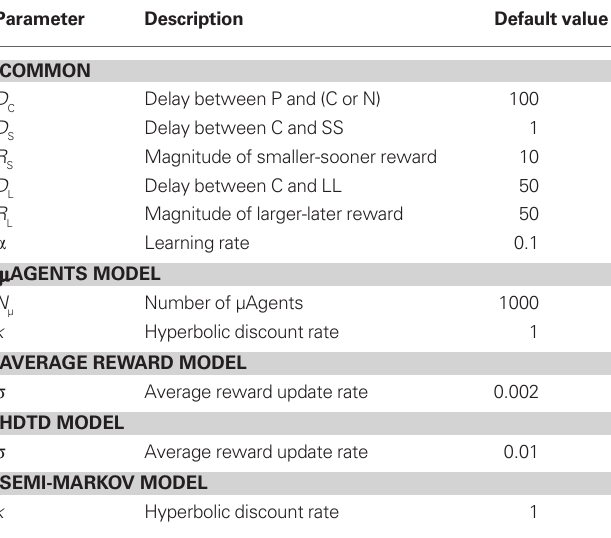
Table 1 | Parameters used in the model (except where noted